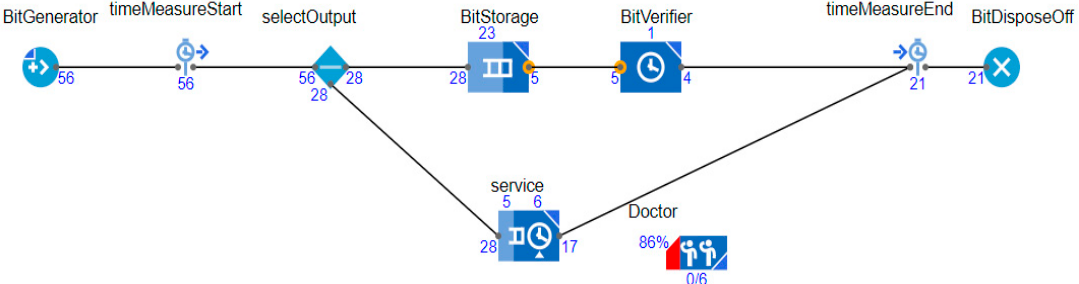
Figure 33. AnyLogicPoG Bit Verifier Circuit for Patient-Doctor Model in Execution.